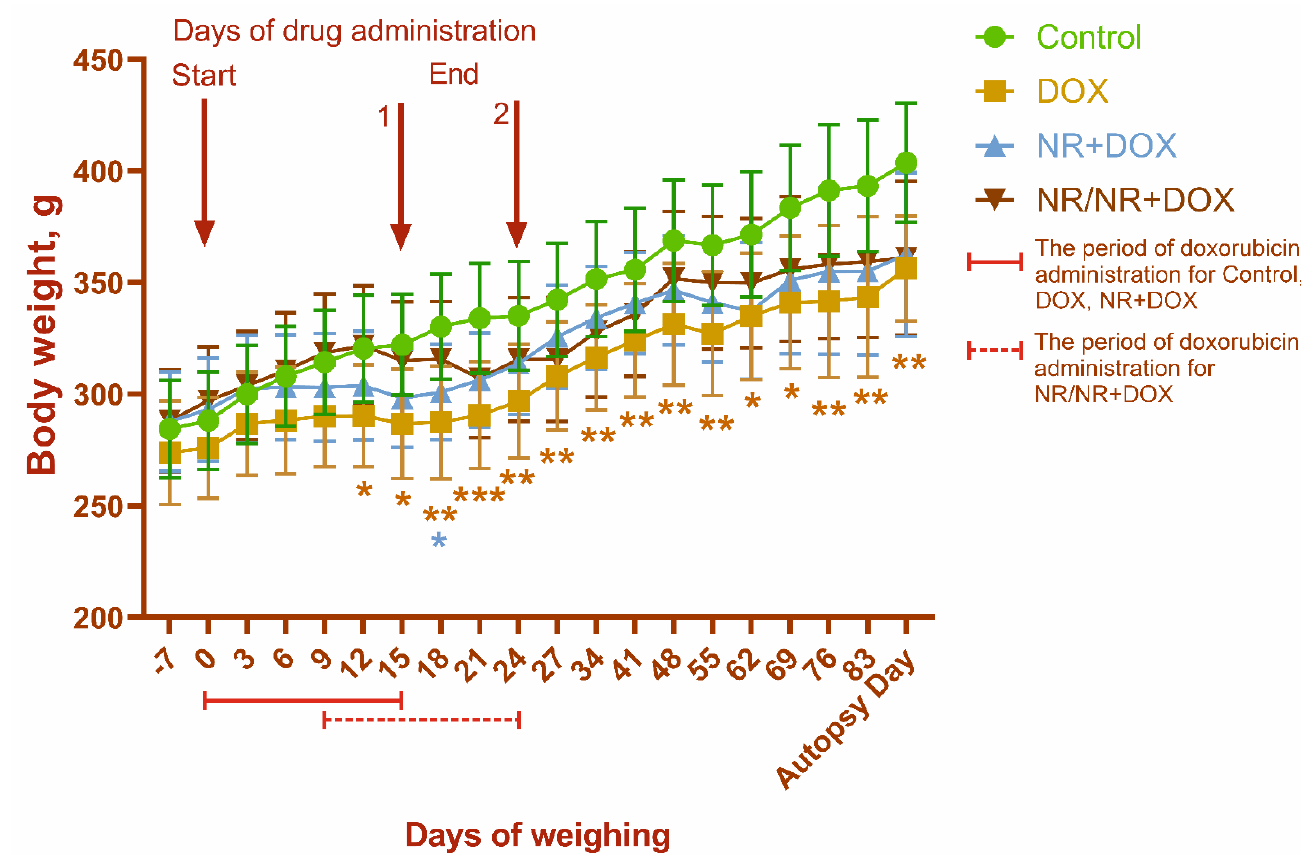
Figure 1. Body − weight dynamics. 1—drug administration endpoint for control, DOX, and NR+DOX groups; 2—drug administration endpoint for NR/NR+DOX group. The first weighing was carried out before the start of each manipulation. During the drug administration, the animals were weighed every 2 days on the day of the substance administration (9 times). At the end of the administration in NR/NR+DOX group, the weight and clinical condition of the animals were monitored once a week. */* — p < 0.05, ** — p < 0.01, and *** — p < 0.001 which shows significant difference compared to control group (* — DOX; * — NR+DOX). Data are presented as median [25%; 75%]. Control represents control group (n = 15); DOX represents doxorubicin group (n = 15); NR+DOX represents nicotinamide riboside + doxorubicin group — combined mode (n = 15); and NR/NR+DOX represents nicotinamide riboside/nicotinamide riboside + doxorubicin group — preventive mode (n = 15). The exercise tolerance significantly decreased within 1 month after the final drug administration in the rats of the DOX and NR+DOX groups ( p < 0.05 compared to the initial value (Start)) (Figure 2). No changes were observed in the control and